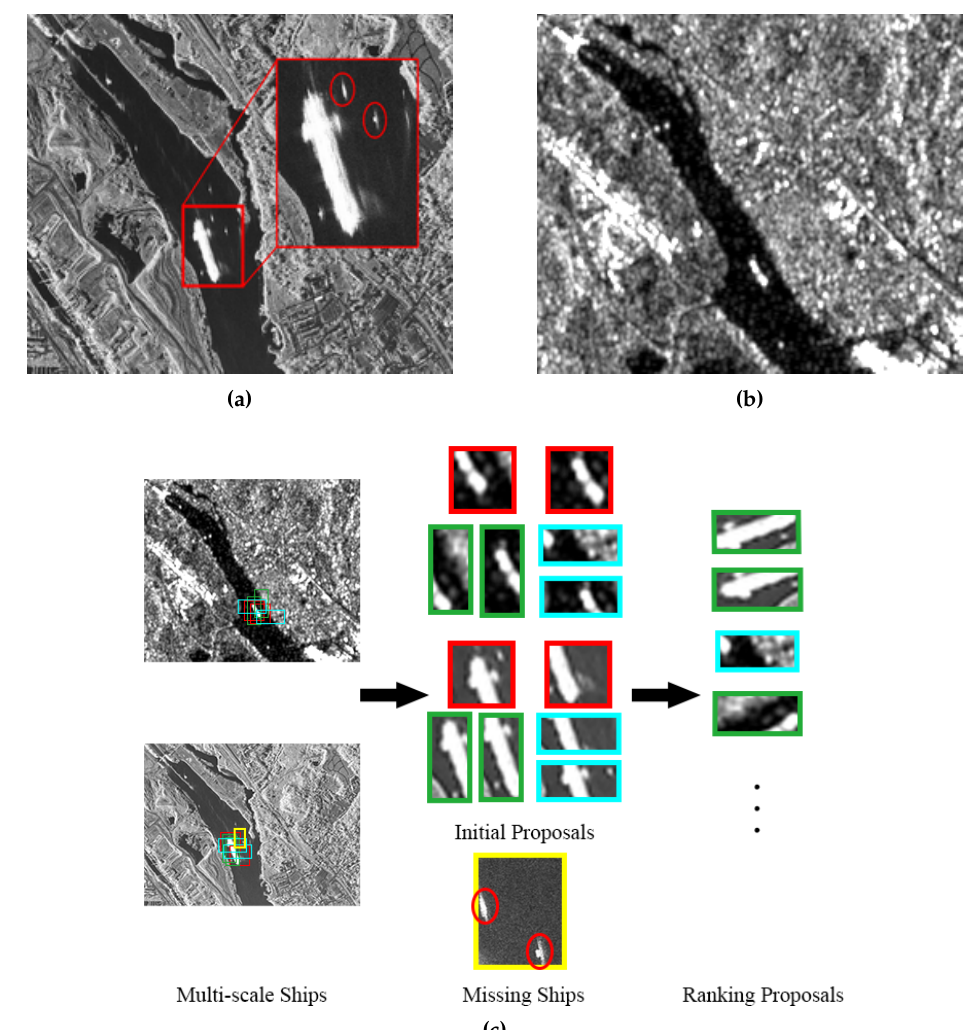
Figure 1. Multi-scale ships in synthetic aperture radar (SAR) images. ( a , b ) can be downloaded at